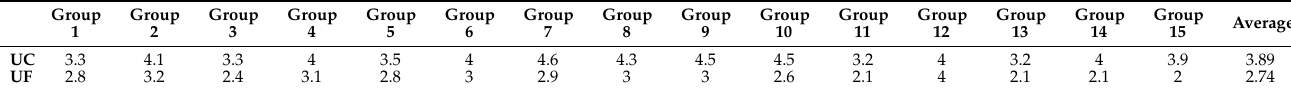
Table 15. UC and UF scores for the activity results.